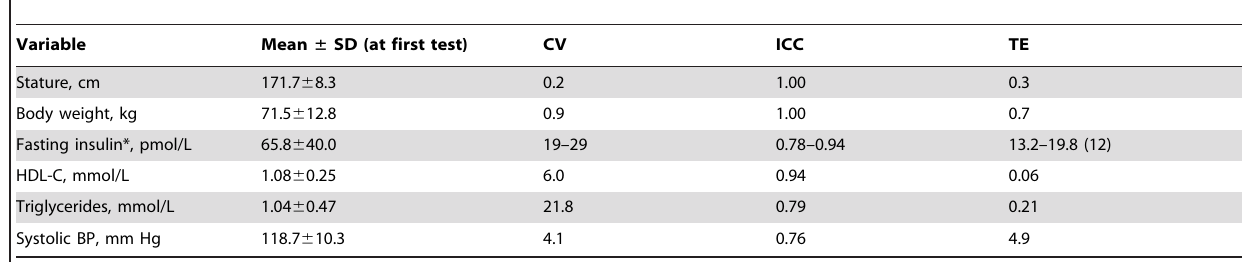
Table 1. Reproducibility of Risk Factors from Measurements Repeated Over 3 Days on 60 Subjects.